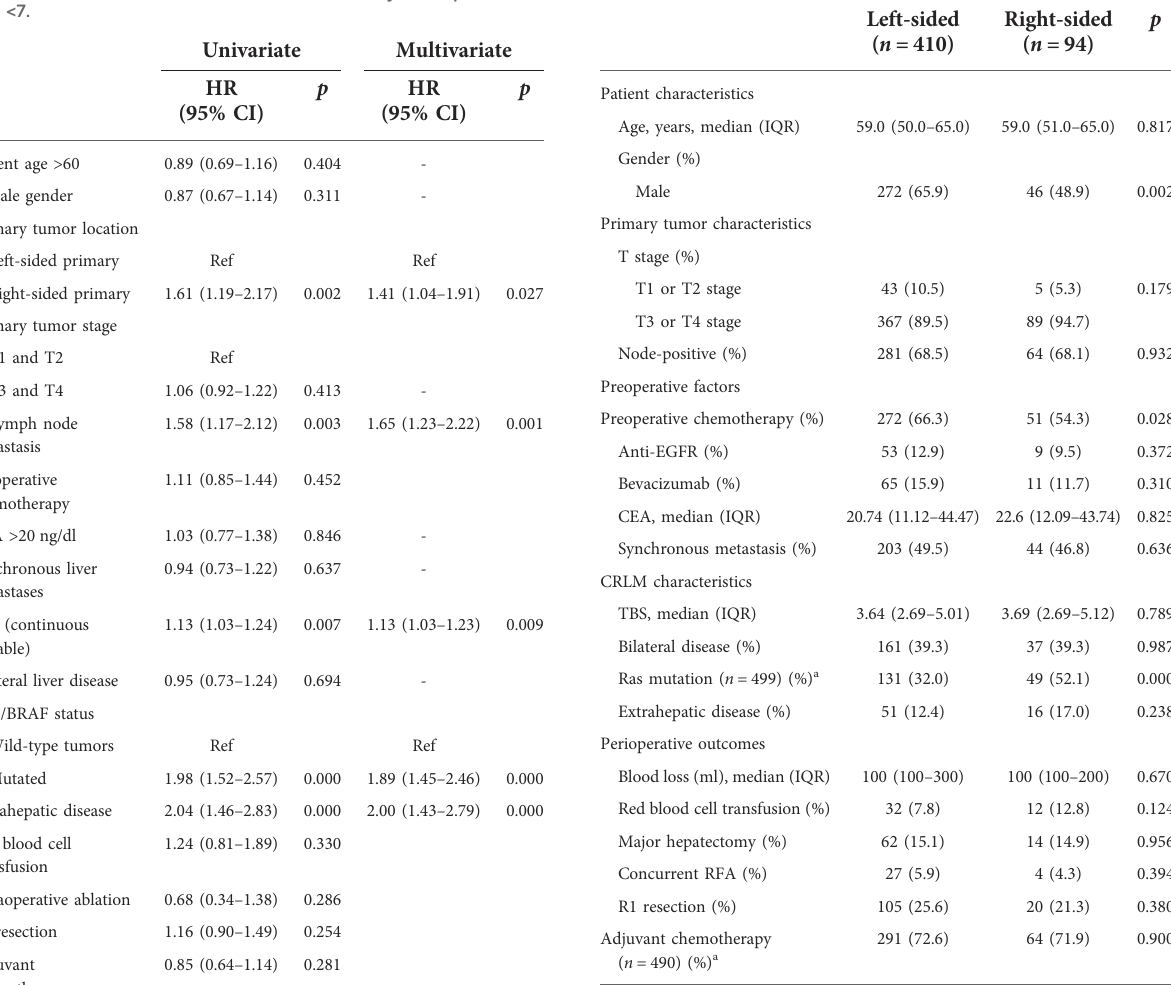
TABLE 4 Clinical, pathological and molecular characteristics strati fi ed according to PTL in patients of TBS <7 ( N